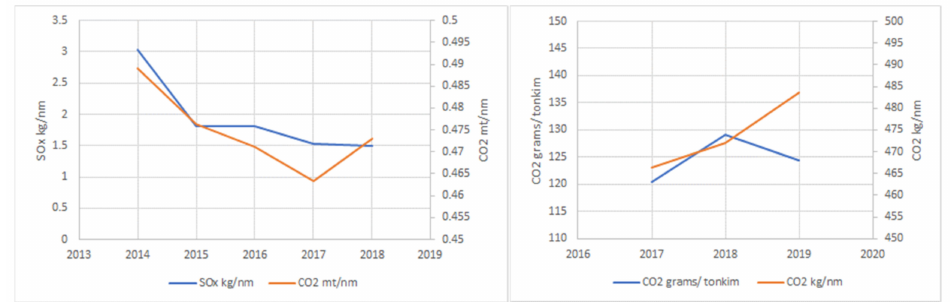
Figure 14. Sustainability Report Stena Line, Emission summary for 2018–2019 and 2019–2020, based on data from